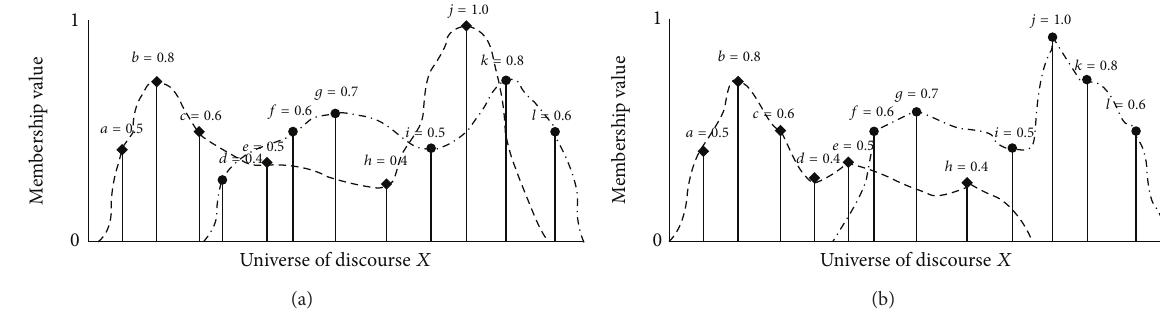
Figure 2: (a) Data distribution between circle and diamond. (b) Data distribution between circle and diamond.